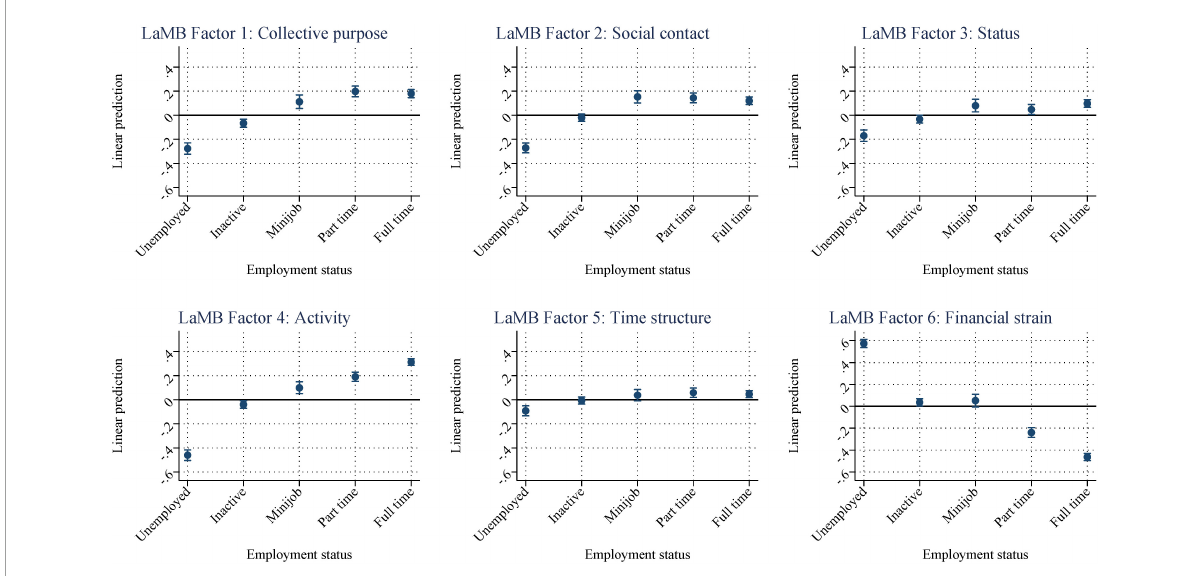
FIGURE1 Standardized LAMB scores by employment status. Supplementary Appendix Table A6 shows the corresponding regression